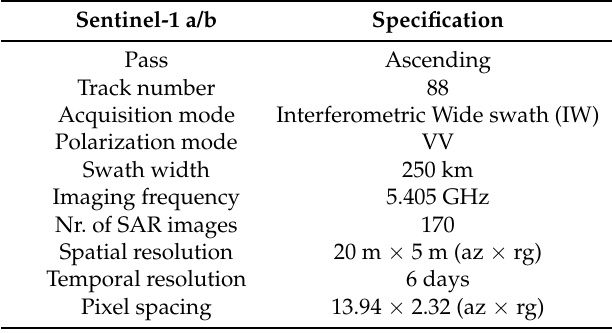
Table 1. Sentinel-1a/b data specification. az, rg are short for azimuth and range direction, respectively.